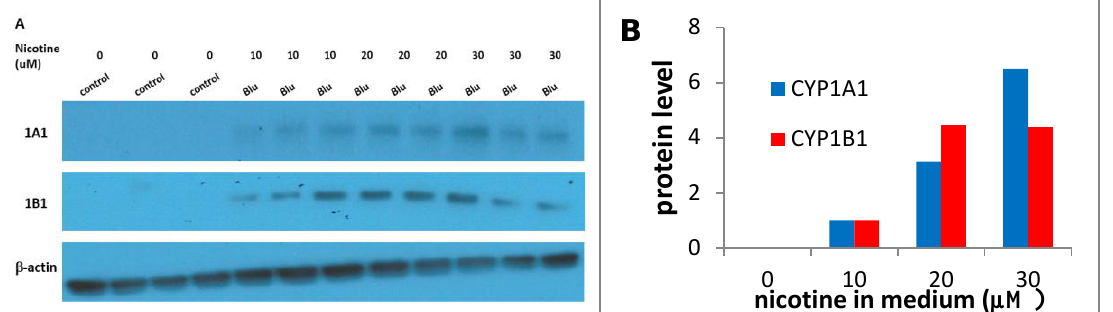
Figure 3. Effect of EAC from blu on CYP1A1 and 1B1 protein levels in MSK Leuk 1 cells. Cells were treated for 24 hr with the blu EAC and CYP1A1 and CYP1B1 protein levels were determined by Western blotting. ( A ) Blotting images; ( B ) Quantitation of images. The levels of CYP1A1 and CYP1B1 were below detection, so the levels of CYP1A1 and CYP 1B1 were normalized to results obtained at 10 uM nicotine, although the enhancement relative to the vehicle control is unknown.